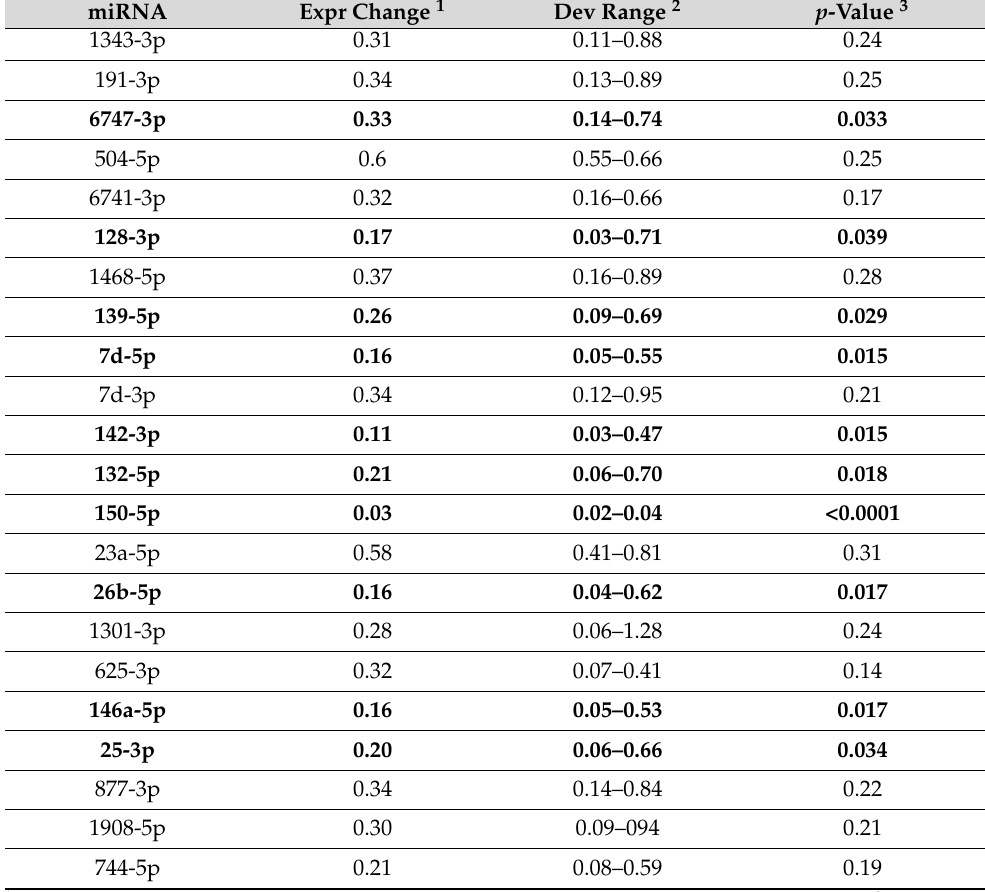
Table 2. Expression changes of the 22 miRNAs identified as deregulated by NGS, in DLB versus controls. First validation study